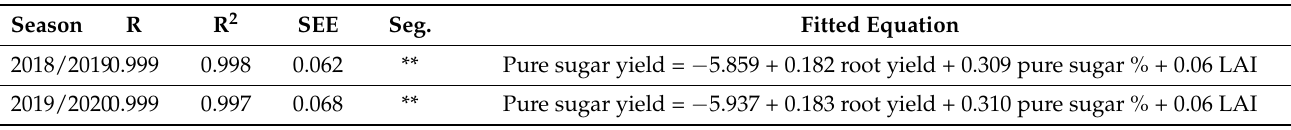
Table 9. Correlation coefficient (r), coefficient of determination (R 2 ), and standard error of the estimates (SEE) for predicting pure sugar yield (Mg ha − 1 ) in two growing seasons under soil salinity (ECe = 8.96 d Sm − 1 ) conditions. Season R R 2 SEE